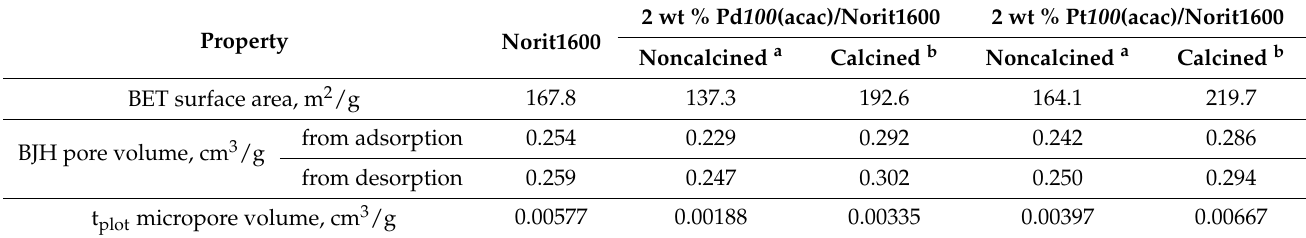
Table 1. Surface areas and pore volume data from N 2 adsorption isotherms. Property